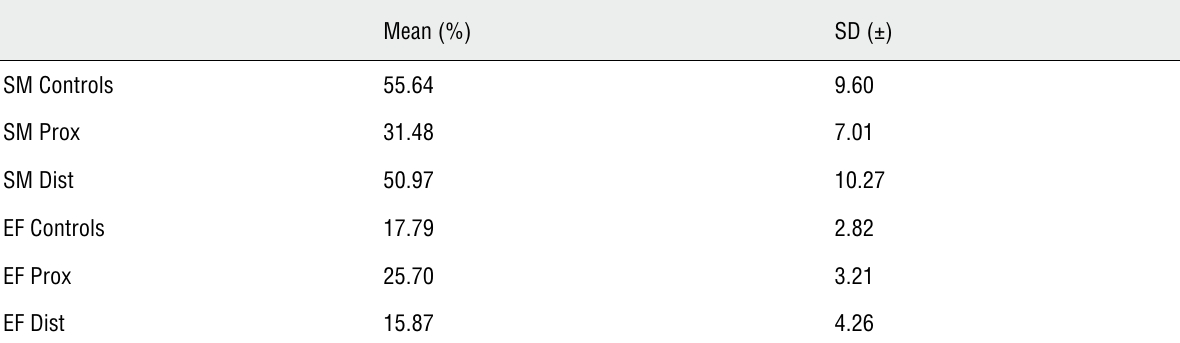
Table 1 - Stereological analysis of smooth muscle and elastic system fibers of urethral